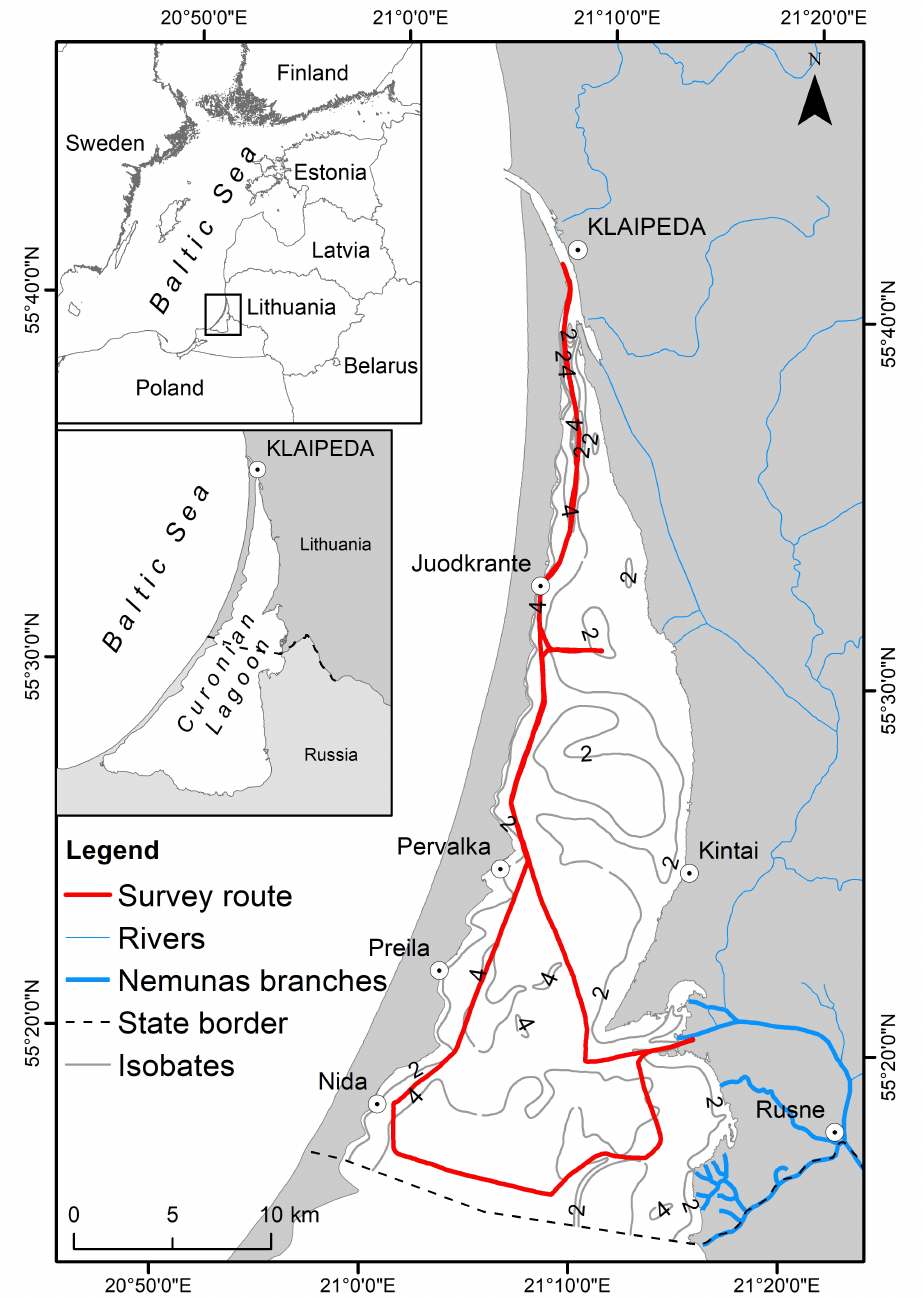
Figure 1. Geographical position of the study area, the Lithuanian part of the Curonian Lagoon in the South-Eastern Baltic